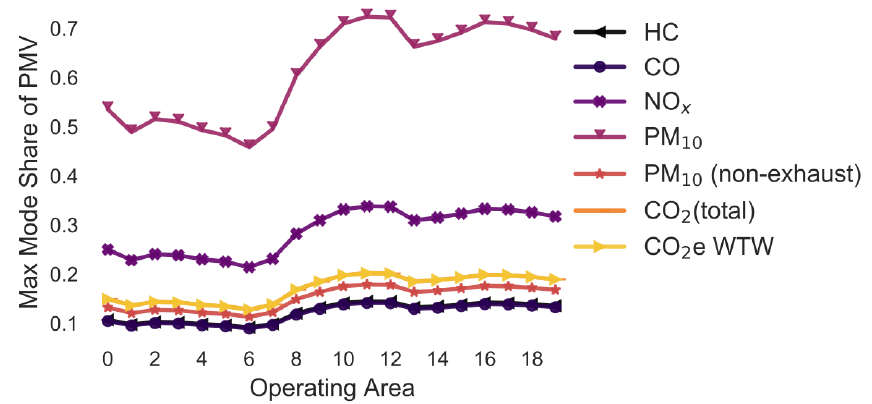
Figure 10. Maximum share of customers who can pick up a parcel by car (varying delivery vehicle drivetrain) (note: CO 2 (total) and CO 2 e WTW are the same).